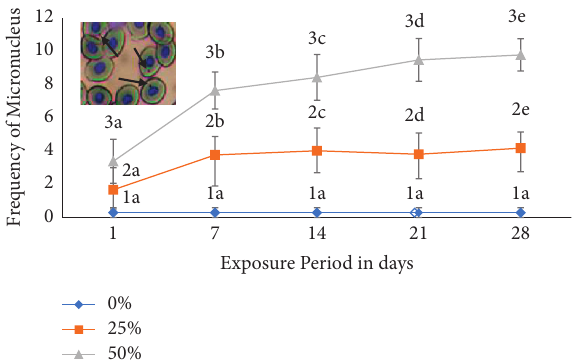
Figure 2: Frequency of micronuclei (MN) in the erythrocytes of silver barb exposed to different sublethal concentrations of malathion. Values with different numeric superscripts differ significantly ( p < 0 . 05) be- tween concentrations within a duration in MN. Values with different letter superscripts differ significantly ( p < 0 . 05) between duration within concentration in MN. All values are expressed as mean ± SD. The photograph in the inset shows MN (arrow).